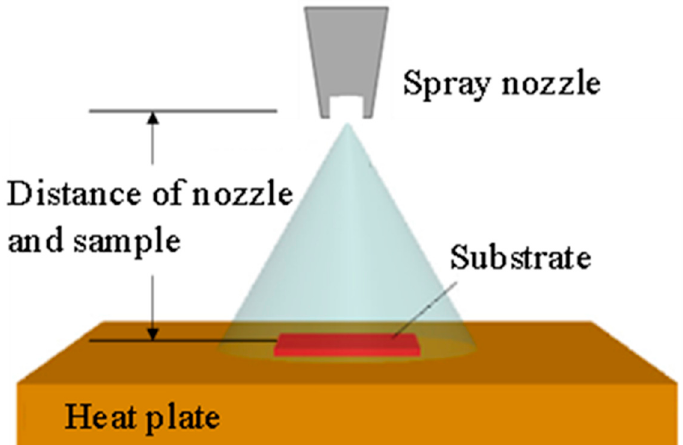
Figure 2. Schematic of spray coating deposition for thin film.